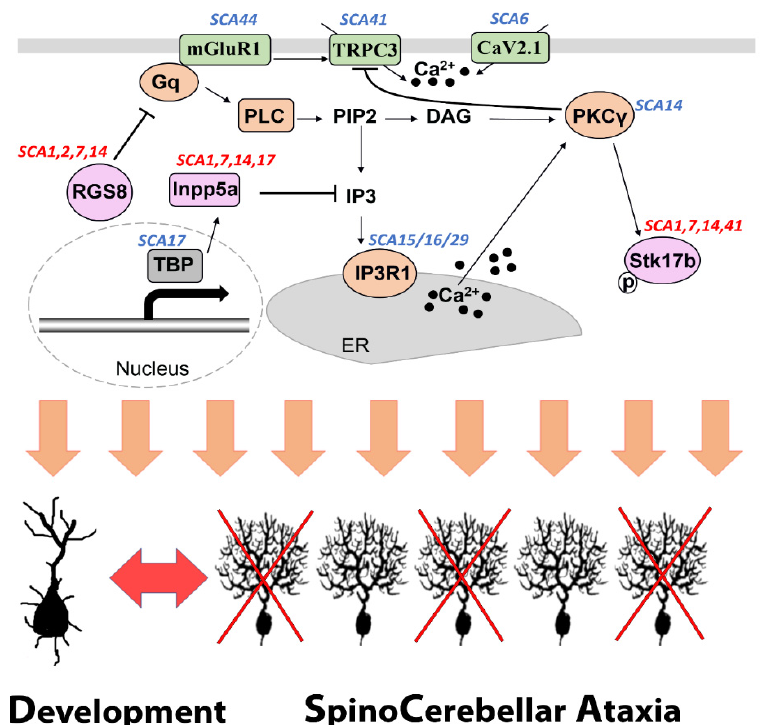
Figure 2. A shared mGluR1-PKC γ signaling pathway associated with SCA pathogenesis and Purkinje cell dendritic development. Several proteins which are components of the mGluR1-PKC γ signaling pathway are encoded by genes mutations of which are known to be causing SCA (labeled in blue). The common molecules RGS8, Inpp5a and Stk17b have been reported to be dysregulated in at least four different forms of SCA (labeled in red) and are directly involved in the mGluR1-PKC γ signaling pathway.